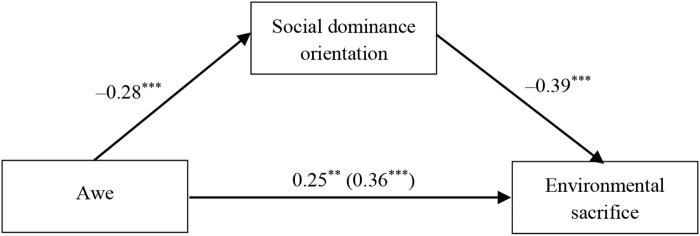
Mediation model for Study 2. ∗∗p < 0.01; ∗∗∗p < 0.001.